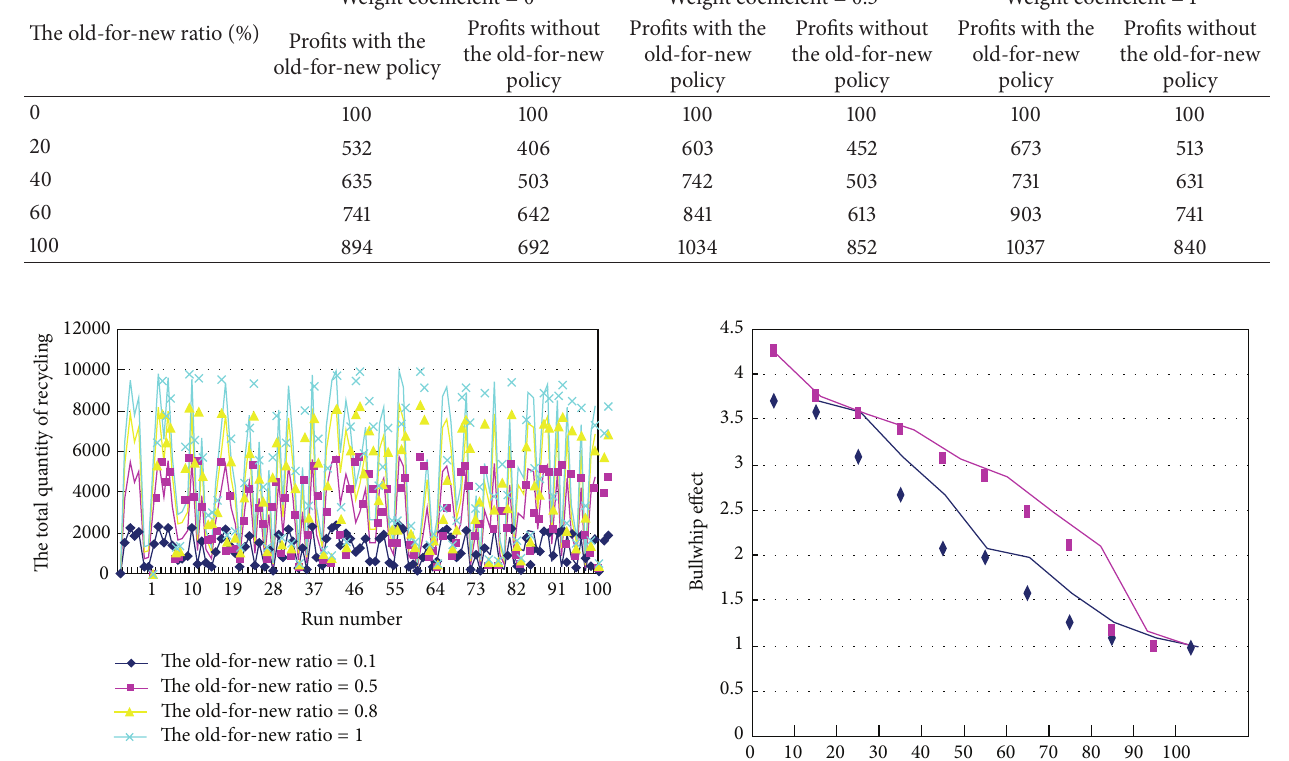
Figure 4: The old-for-new policy impact on quantity of recycling.